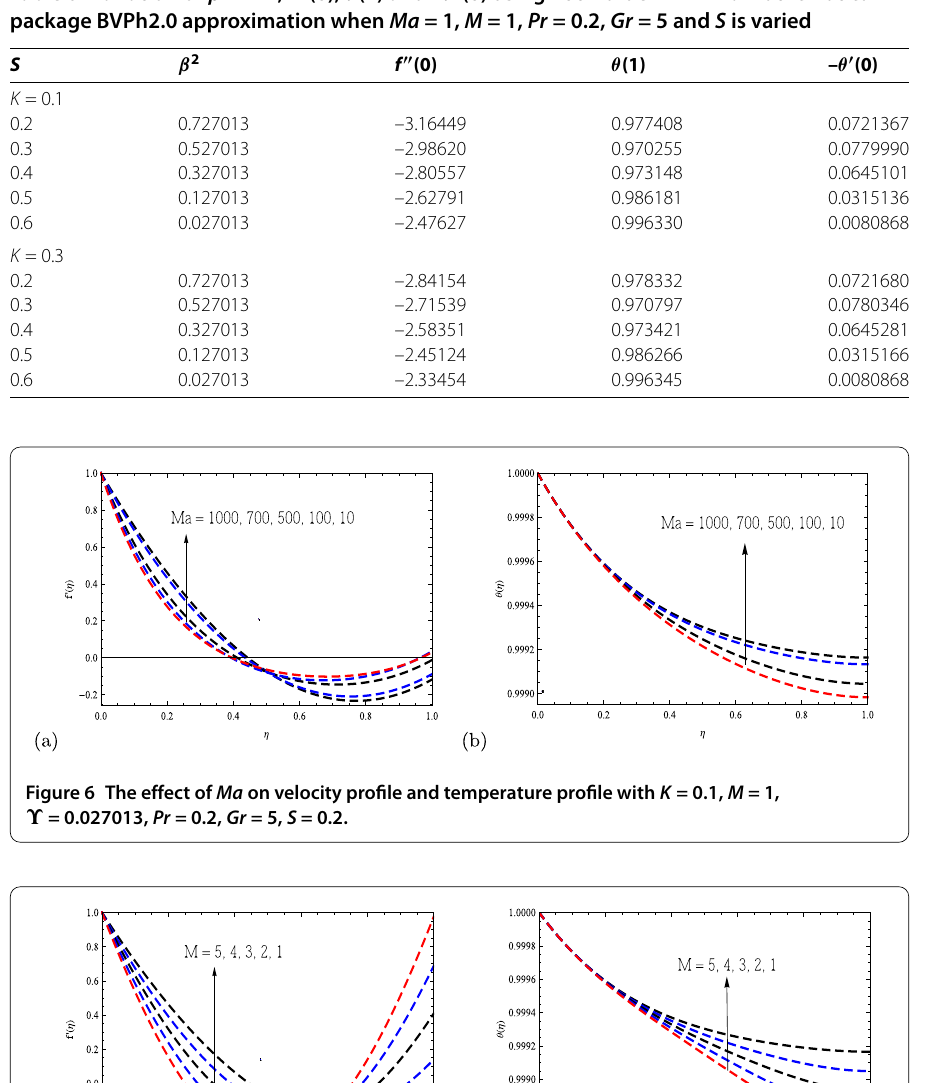
Table 8 Variation of β 2 = ϒ , f (cid:2)(cid:2) (0), θ (1) and – θ (cid:2) (0) using 20th-order HAM via Mathematica